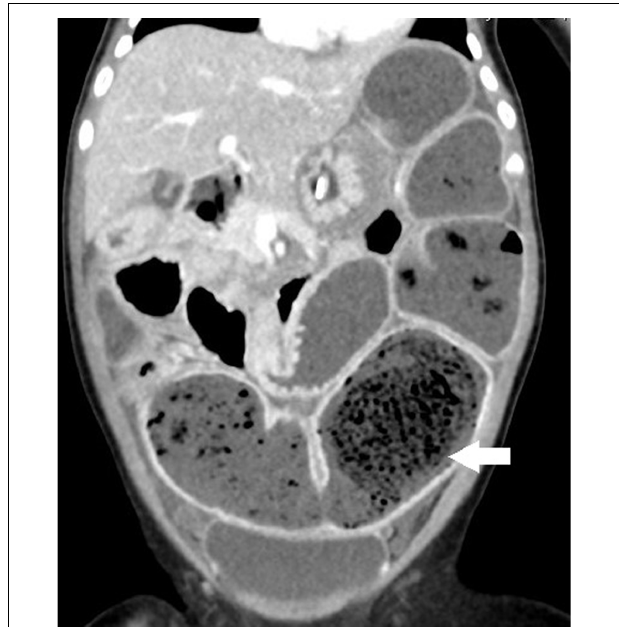
FIGURE 2 | The coronal section of abdominal computed tomography (CT) discloses a prominent dilated bowel loop with air bubble-interspersed feces (lactobezoar) at the left lower quadrant (white